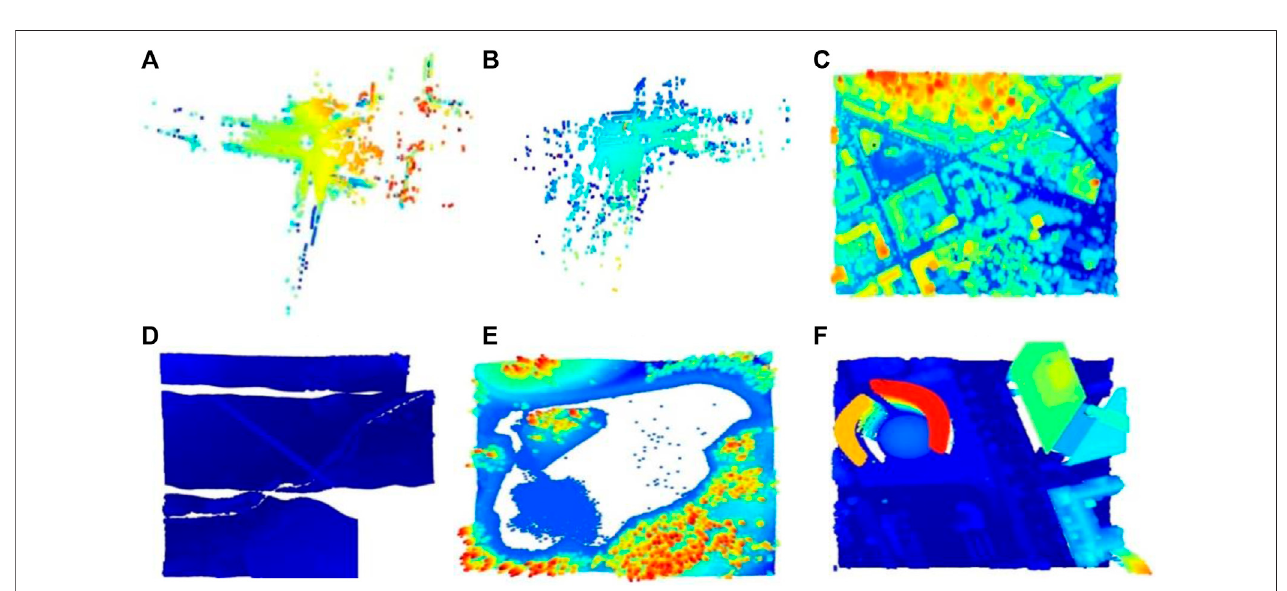
FIGURE 2 | Input sample images from three different datasets (A) Scan2446(S) (B) Scan23124(S) (C) Csite3(I) (D) Fsite8(I) (E) Lake(L) (F) Building(L).